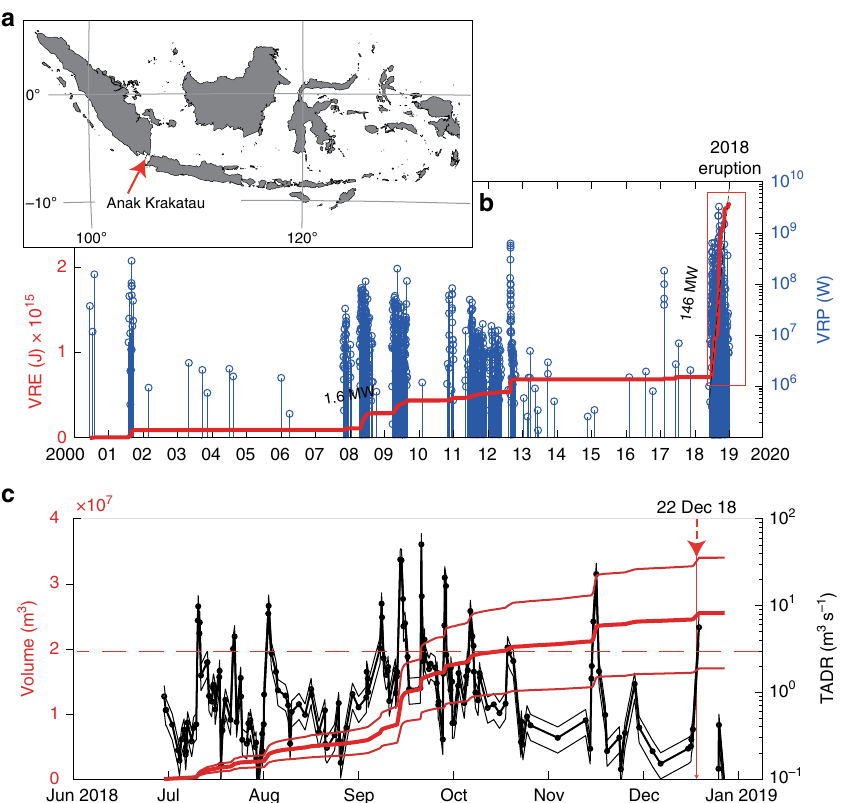
Fig. 1 Elevated volcanic activity prior to sector collapse. a Location of Anak Krakatau. Coastline map created using the GMT/MATLAB Toolbox 59 . b Multiyear time series of the volcanic radiative power (VRP) and cumulative volcanic radiative energy (VRE) recorded as MODIS data at Anak Krakatau. A sharp increase in thermal activity started on 30 June 2018, marking the beginning of a new eruptive phase that culminated in the collapse of the edi fi ce on 22 December 2018. The red rectangle marks the recent eruptive period shown in detail in Fig. 3. c Time-averaged discharge rate (TADR) derived from satellite thermal data during the June – Dec 2018 eruption. Note the occurrence of 11 pulses with a TADR above 3 m 3 s − 1 (dashed line) associated with effusive paroxysms that produced lava fl ows. The cumulative erupted volume (red line) indicates a gradual decline in effusive activity after Oct